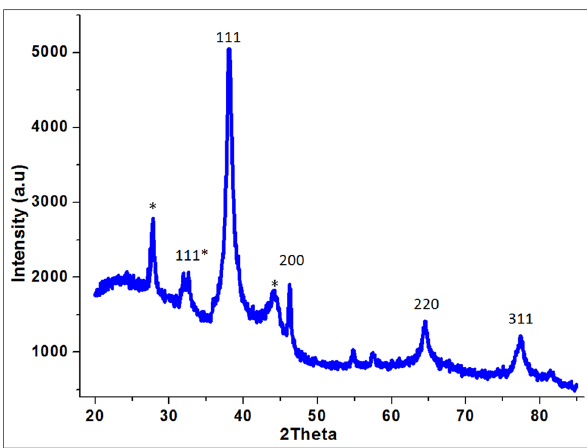
Figure 2: Powder XRD pattern of AgNPs.